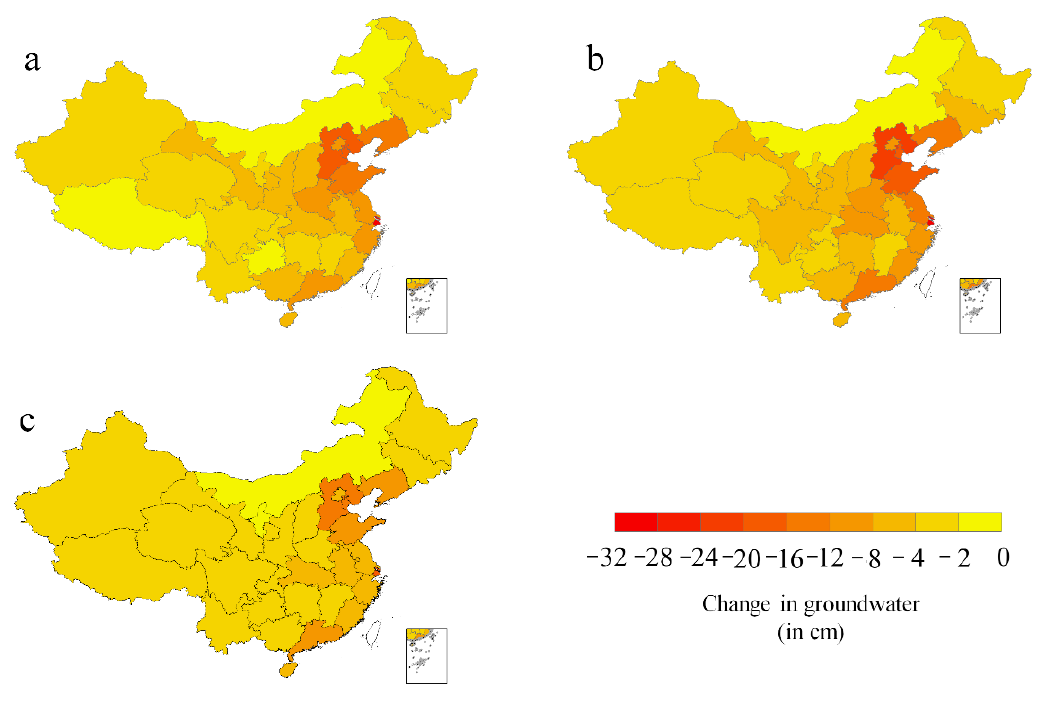
Figure 4. Mean changes in groundwater storage projected for ( a ) optimistic scenarios RCP4.5 and SSP2 ( b ) business-as-usual scenarios RCP8.5 and SSP2 and ( c ) pessimistic scenarios RCP8.5 and SSP3. Changes are represented by difference in groundwater between future (2041 – 2050) and cur- rent (2003 – 2015).